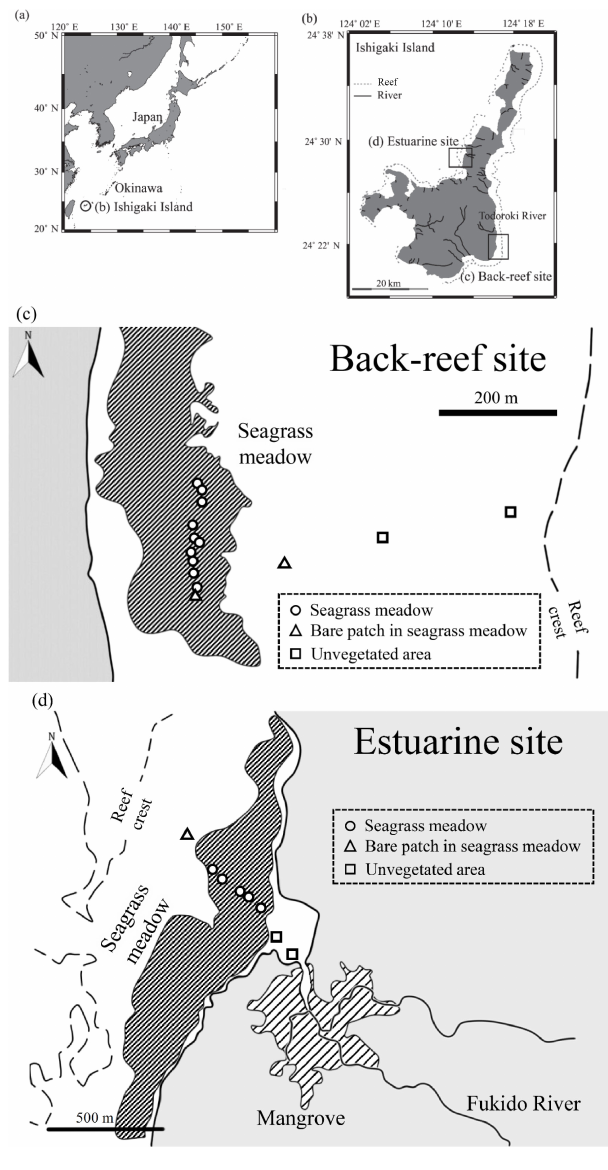
Figure 1. Study sites. (a, b) Study site location on Ishigaki, Japan. Sampling points at (c) the back-reef site and (d) the estuarine site. At the back-reef site, the circle indicating the southernmost vege- tated sampling point actually represents a cluster of six sampling